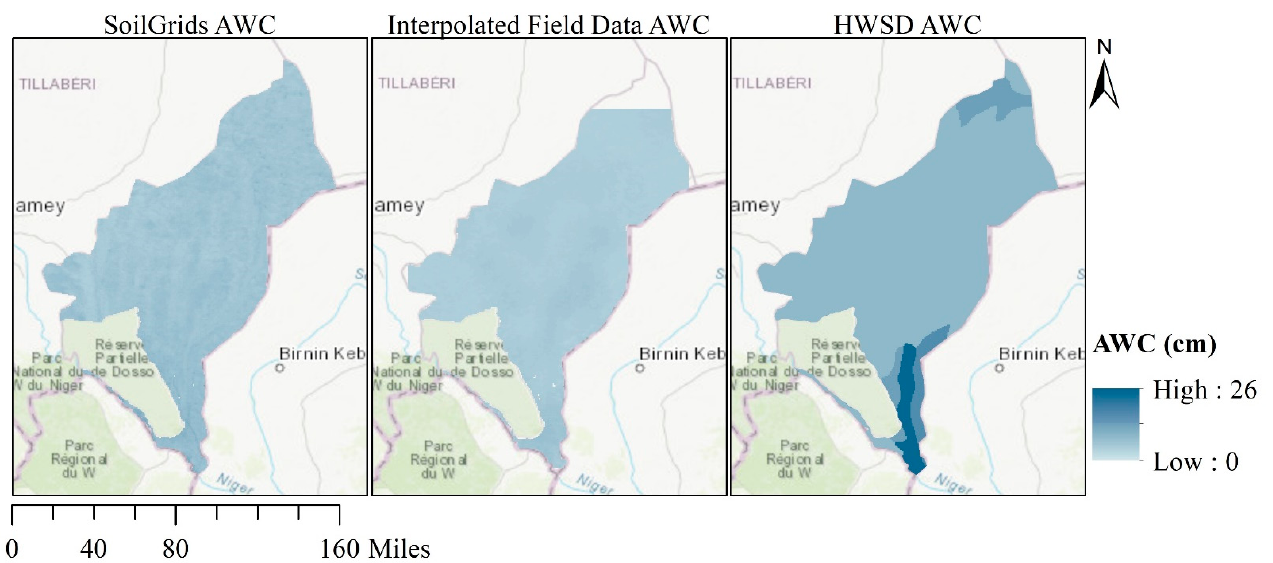
Figure 7. Calculated AWC for SoilGrids, field data, and HWSD. AWC is a function of soil texture, rock fragment content, and organic matter. AWC is measured in centimeters and is calculated to 100 cm depth.